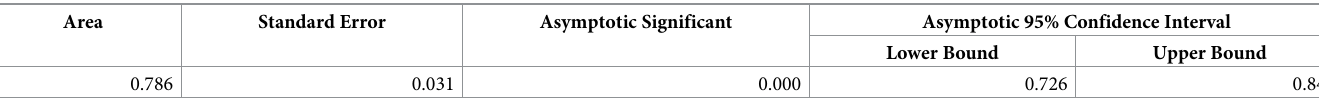
Table 2. Area under the curve based on data from March 20,